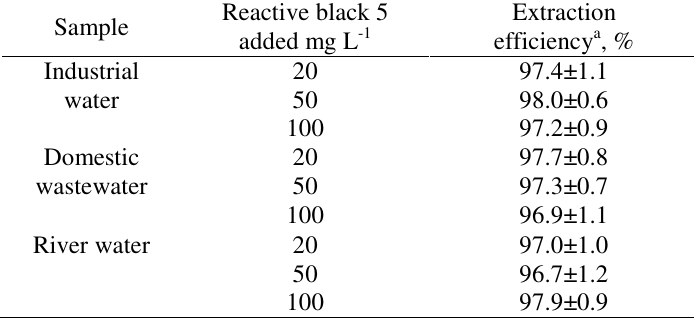
Table 2. The effect of foreign species on the determination of 20 mg L -1 of RB 12 Foreign species tolerance ratio, w/w Na + , Cd 2+ , Mg 2+ , Ca 2+ , NH 4+ , I - , Bi + , NO 2- , Br - , F - , HPO 42- , Zn 2+ , SO 32- , Mn 2+ 1500 Ag + , Sr 2+ , CH COO - , Li + 3 Pb 2+ , SCN - , Ba 2+ 1000 Cu 2+ , CO 2+ , ClO 4- 800 Direct yellow 12 (dye) 150 Direct red (dye) Golden yellow (dye) Reactive black 22 (dye) 25 Table 3. Removal of reactive black 5 in spiked water samples Reactive black 5 Sample added mg L -1